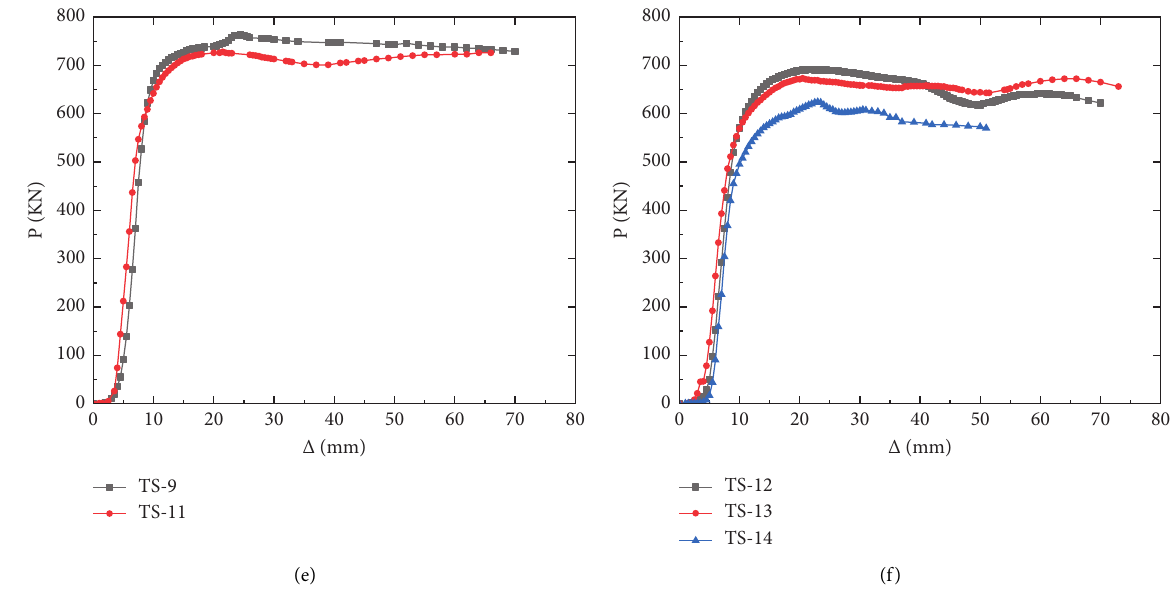
Figure 4: Load-displacement curve with different RCA